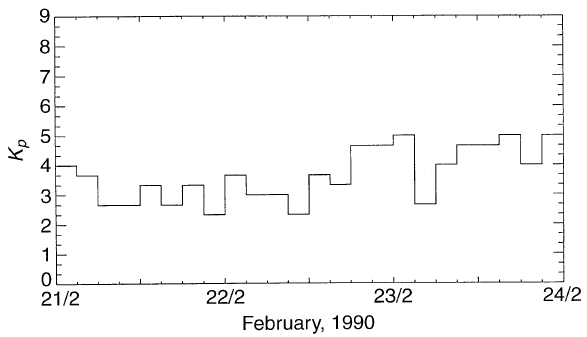
Fig. 11. Kp indices for 21 — 23 February